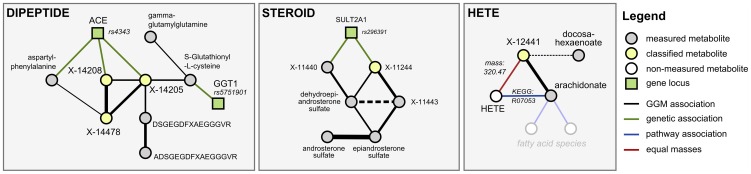
Detailed investigation of three scenarios (DIPEPTIDE, STEROID, and HETE).In order to generate concrete hypotheses on the unknowns' identities, we assembled all available information for each scenario. This includes biochemical edges from the GGM, genetic associations from the GWAS, pathway annotations as well as mass information. For details of the predicted identities, see Table 3 and main text. Similar figures for three further scenarios (CARNITINE, BILIRUBIN, and ASCORBATE) are available in Text S3.